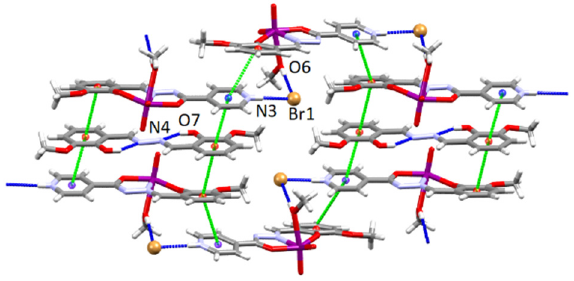
Figure 5. The crystal packing of the [1H]Br·0.5VA . Intramolecular O7–H71 ⋯ N4 and intermolecular hydrogen bonds O6 − H61 ⋯ Br1 and N3 − H3 ⋯ Br1 are shown by blue dotted lines. Green dashed lines indicate π -stacking interactions (Cg3 is centre of gravity of the pyridyl ring, blue spheres and Cg4 and Cg5 are centres of gravity of the phenyl ring, red spheres).